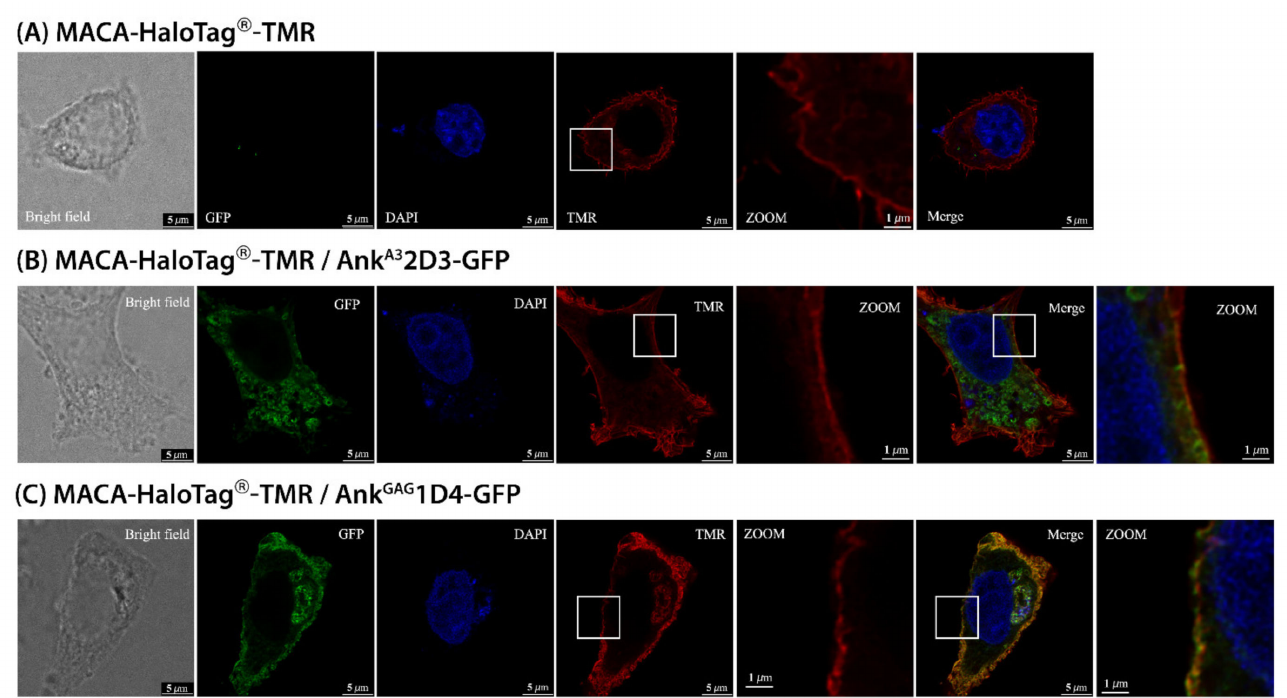
(Figure 4A). The molar ratio of pNL4-3 ∆ env to pCEP4-Myr (+) Ankyrin at 1:1 was not appropriate since the amount of generated virion was not sufficient for further analysis (Figure 1A). we diminished the inhibitory effect of Ank GAG 1D4 in HIV-1 transfected cells, the molar ratio of pNL4-3 ∆ env to pCEP4-Myr (+) Ankyrin was adjusted to 2:1 for sufficient virions collected to analyse their RNA contents by RT-qPCR. The results showed that both Ank GAG 1D4 and Ank A3 2D3 decreased the intravirion levels of viral RNAs (FL, MS, and env) and cellular RNAs (U6 small nuclear RNA (snRNA) and 7SL), compared to HEK293T cells expressing HIV-1 ∆ env alone (Figure 4B). Ank GAG 1D4 reduced the intravirion viral and cellular RNA levels much more than Ank A3 2D3 (except for 7SL RNA; Figure 4B).